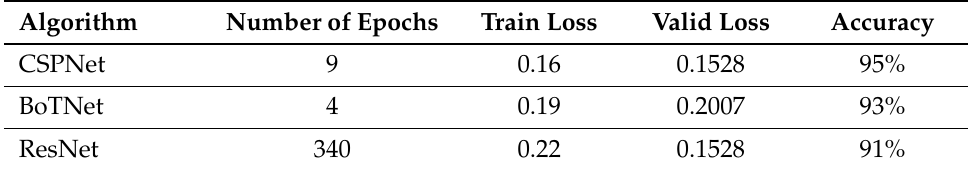
Table 3. The result of three